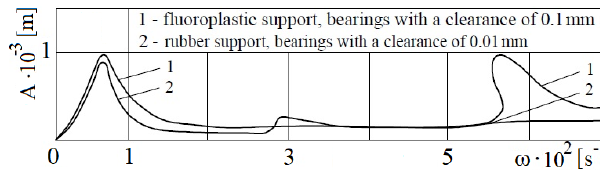
Figure 24. Amplitude-frequency characteristic of the centrifugal rotor in different versions of the support